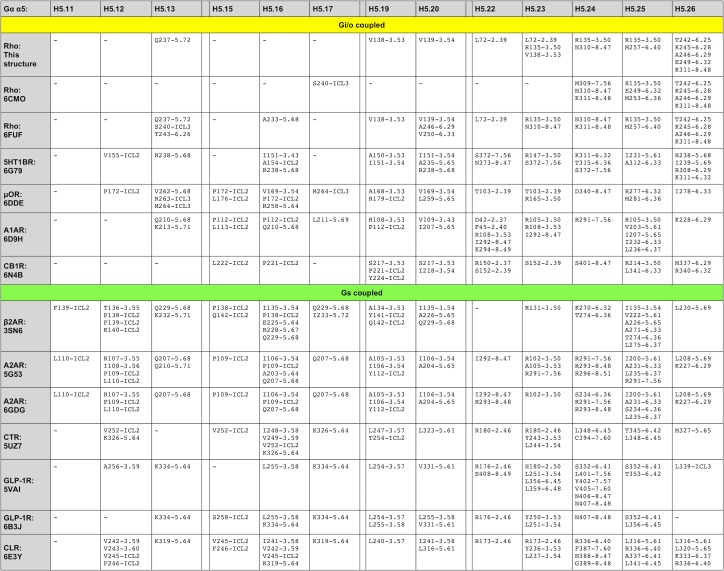
Residue-residue contacts between GPCRs and Gα H5.11–26.